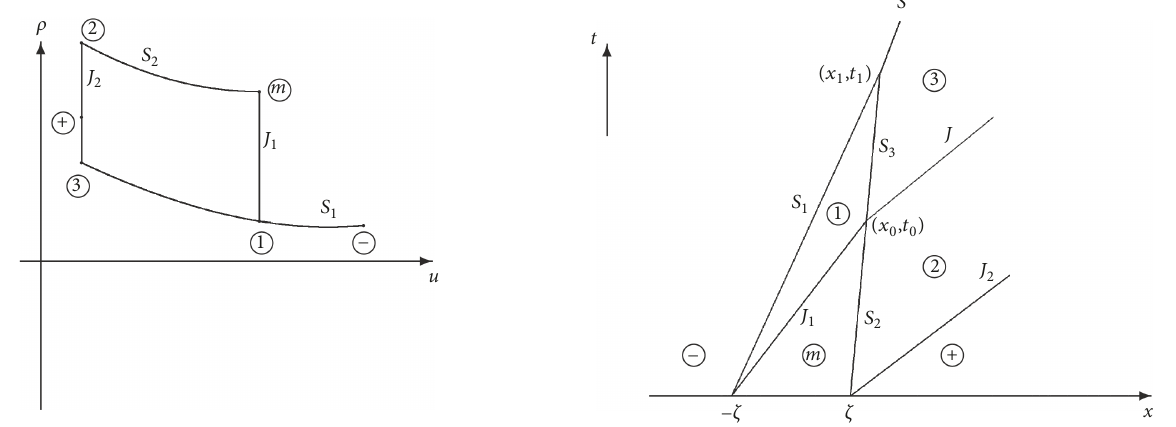
Figure 2: Wave interactions as 𝑢 + < 𝑢 𝑚 < 𝑢 −